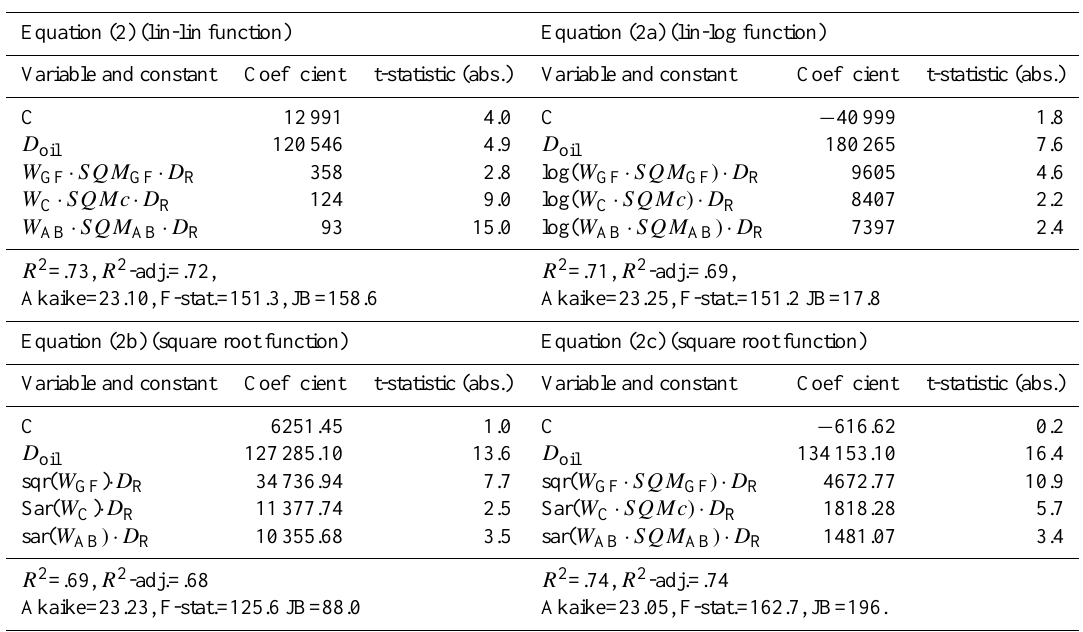
Table 5. Regression analysis (Eqs. 2, 2a, 2b and 2c).